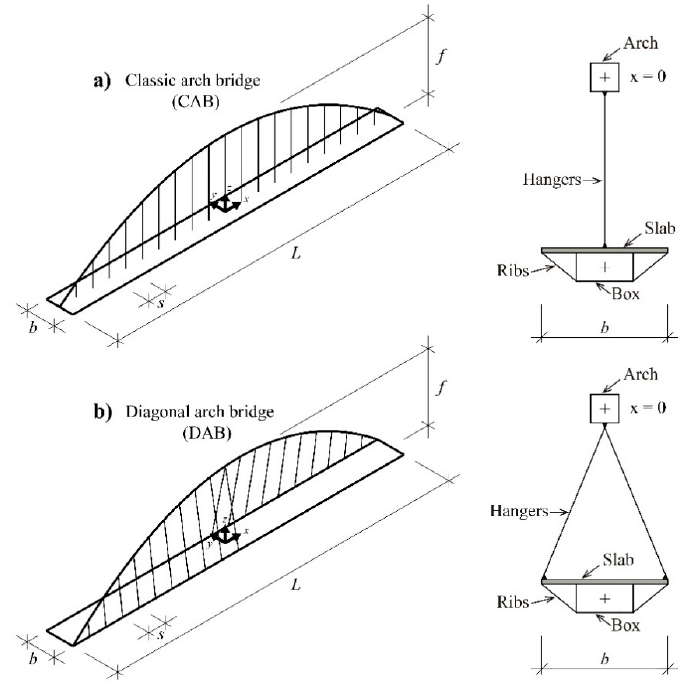
Figure 28. Reference bridges: ( a ) classical arch bridge (CABs) and ( b ) diagonal arch bridge DABs. Both bridges have a span, L = 100 m, and a rise, f = 20 m. The spacing between